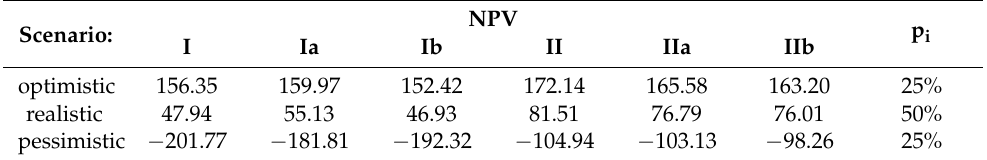
Table 5. NPV and probability in optimistic, realistic and pessimistic scenarios for variant II.